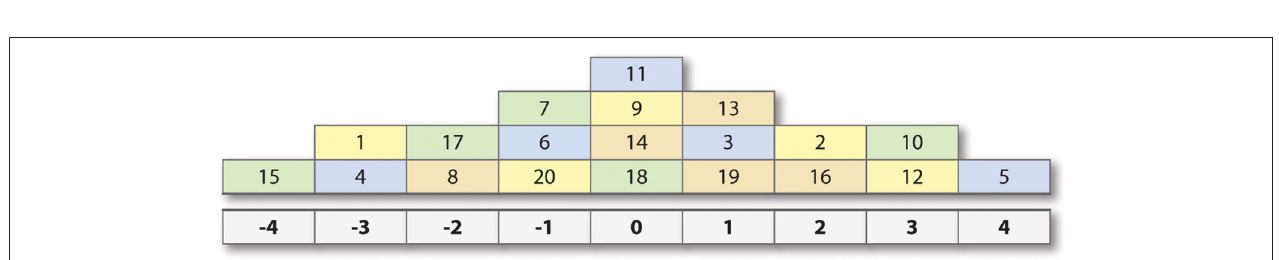
FIGURE 3 | Ideal sort for factor 1. Factor name was chosen based on statements 7 and 14. Color coding is based on the four pillars of sustainability (green = biological sustainability, blue = economic sustainability, Red = social sustainability, and yellow = institutional sustainability).